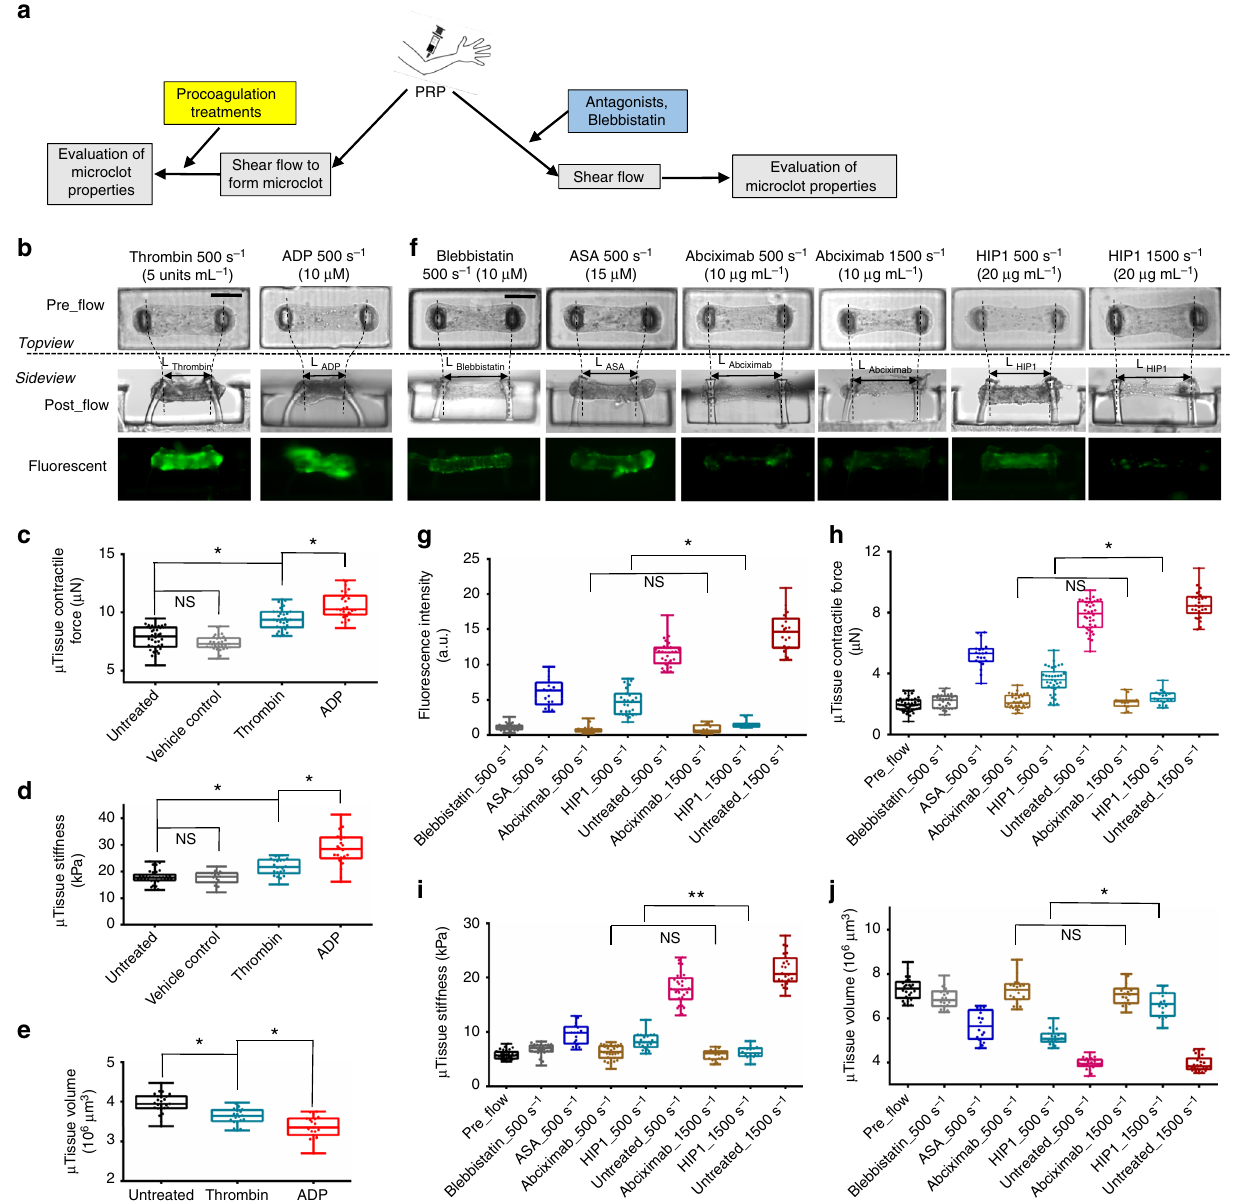
Fig. 4 Microclot mechanics under platelet agonist and antagonist treatments. a Overview of the approaches. b Phase contrast and fl uorescence images of microclots after 10 μ M ADP or 5 U mL − 1 thrombin treatment under fl ow. These microclots were fi rst formed over 30 min of 500 s − 1 platelet fl ow prior to agonist introduction for an additional 10 min. Measured contractile force ( c ), stiffness ( d ) and volume ( e ) of microclots after various procoagulation treatments. f Phase contrast and fl uorescence images of microtissues formed after 30 min of 500 or 1500 s − 1 platelet fl ow treated with blebbistatin, acetylsalicyclic acid (ASA), abciximab (anti GPIIb/IIIa) or HIP1 (anti-GpIb α ) antibody. Measured fl uorescence intensity ( g ), contractile force ( h ), stiffness ( i ) and volume ( j ) of microtissues formed under above anticoagulation treatments. ** P < 0.05, * P < 0.005, n > 10, each dot in box plot represents an independent experiment. All box plots with whiskers represent the data distribution based on fi ve number summary (maximum, third quartile, median, fi rst quartile, minimum). Statistical signi fi cance was determined by one-way analysis of variance (ANOVA). Scale bar is 200 µ